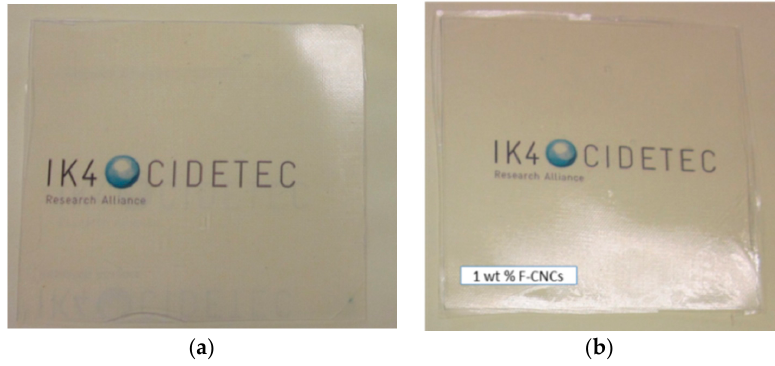
Figure 5. Poly (lactic acid) (PLA) nanocomposite films prepared by hot pressing: ( a ) neat PLA and ( b ) PLA with 1 wt % of F-CNCs.